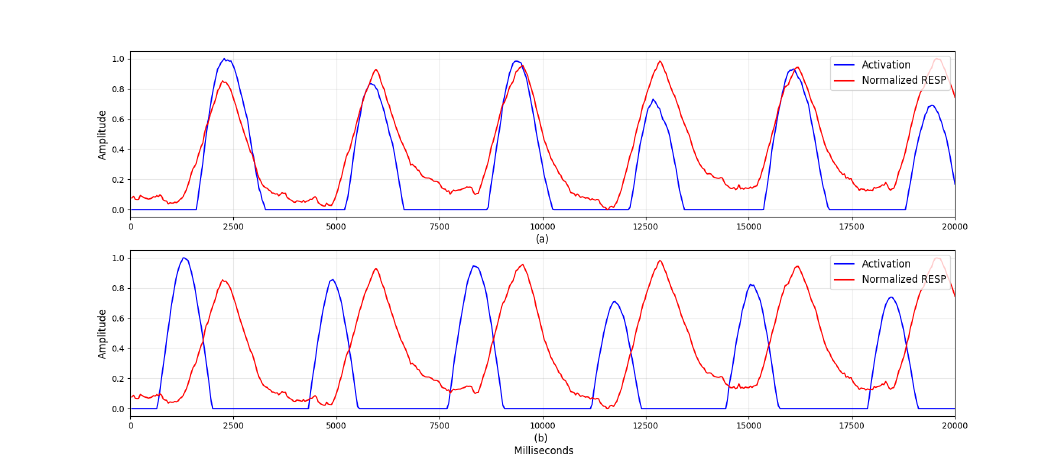
Figure 5. The activations on the first ReLU of respiration (RESP) signal. To easily see which signal patterns were activated, the activations and the first batch-normalization layer’s outputs were normalized with MinMax Scaler having a range from 0 to 1. The blue line indicates the activations and the red line indicates the output. Activations around ( a ) RESP peak (e.g., inspiration) and ( b ) RESP nadir (e.g.,